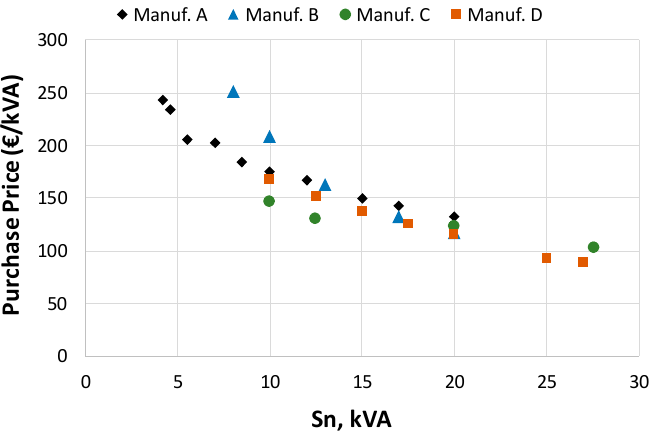
Figure 7. Unit cost of purchasing of 3-phase PV inverters in Greece in July 2020. Data from same retailer for four different inverter manufactures.